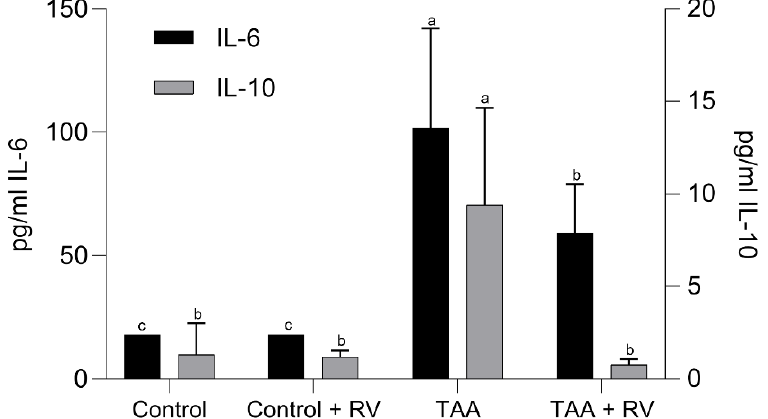
Figure 4. Effect of resveratrol and ε -viniferin on levels of proinflammatory (IL-6) and anti- inflammatory (IL-10) cytokines in the liver of rats with experimental severe acute liver failure using multiplex analysis. Values are expressed as the mean ± standard deviation. Lowercase letters indicate significant differences between treatments ( p < 0.05), n = at least 4. RV: resveratrol + ε -viniferin; TAA: